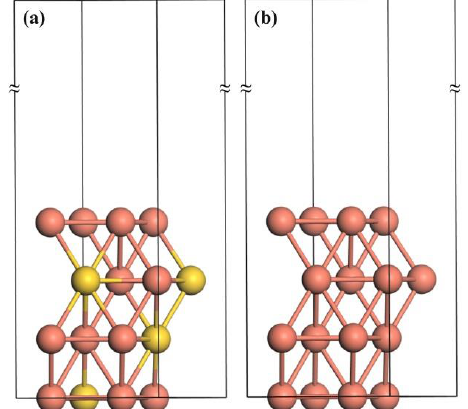
Figure 1. The slab models consist of ( a ) Cu-skin Cu 3 Au(111) surface, ( b ) pure Cu(111) surface. In the figure, brick-red and gold balls represent Cu and Au atoms, respectively.